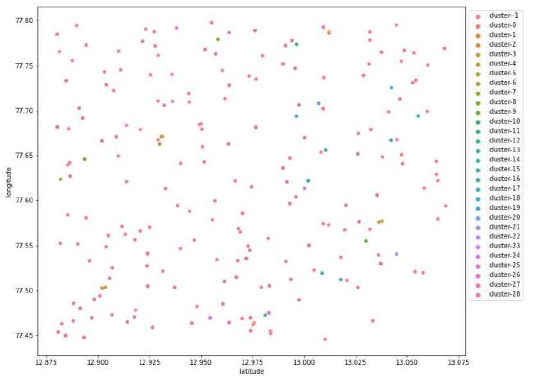
Figure 11. Cluster formation of DBSCAN with eps=6